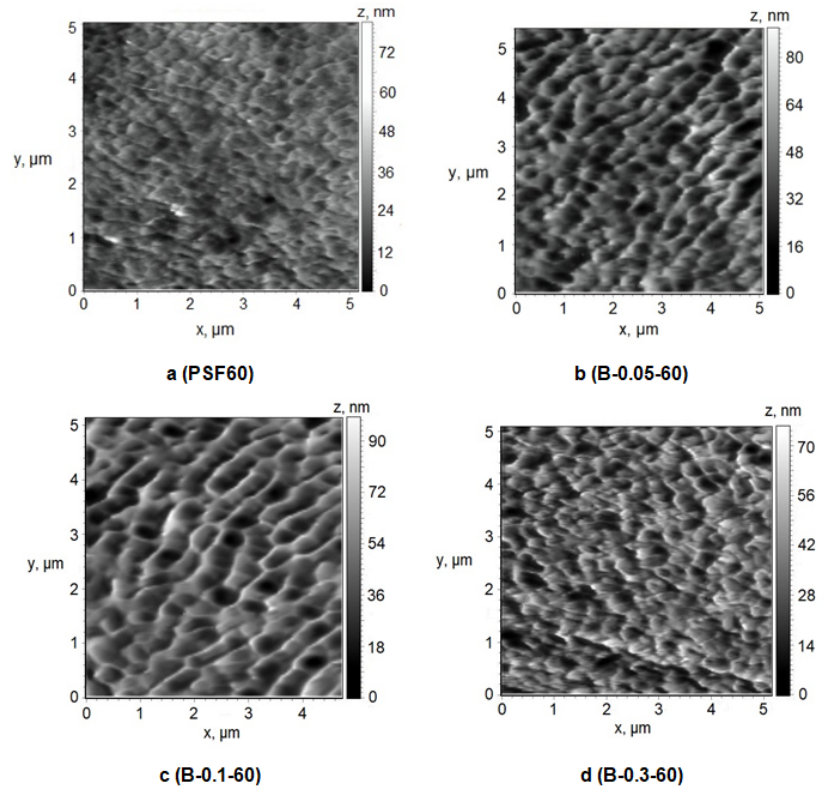
Figure 9. Atomic force microscopy (AFM) images of the surface of the selective layer, Praestol 859 concentration in the coagulation bath ( T = 60 °C), wt. %: ( a ) 0; ( b ) 0.05; ( c ) 0.1; ( d ) 0.3.